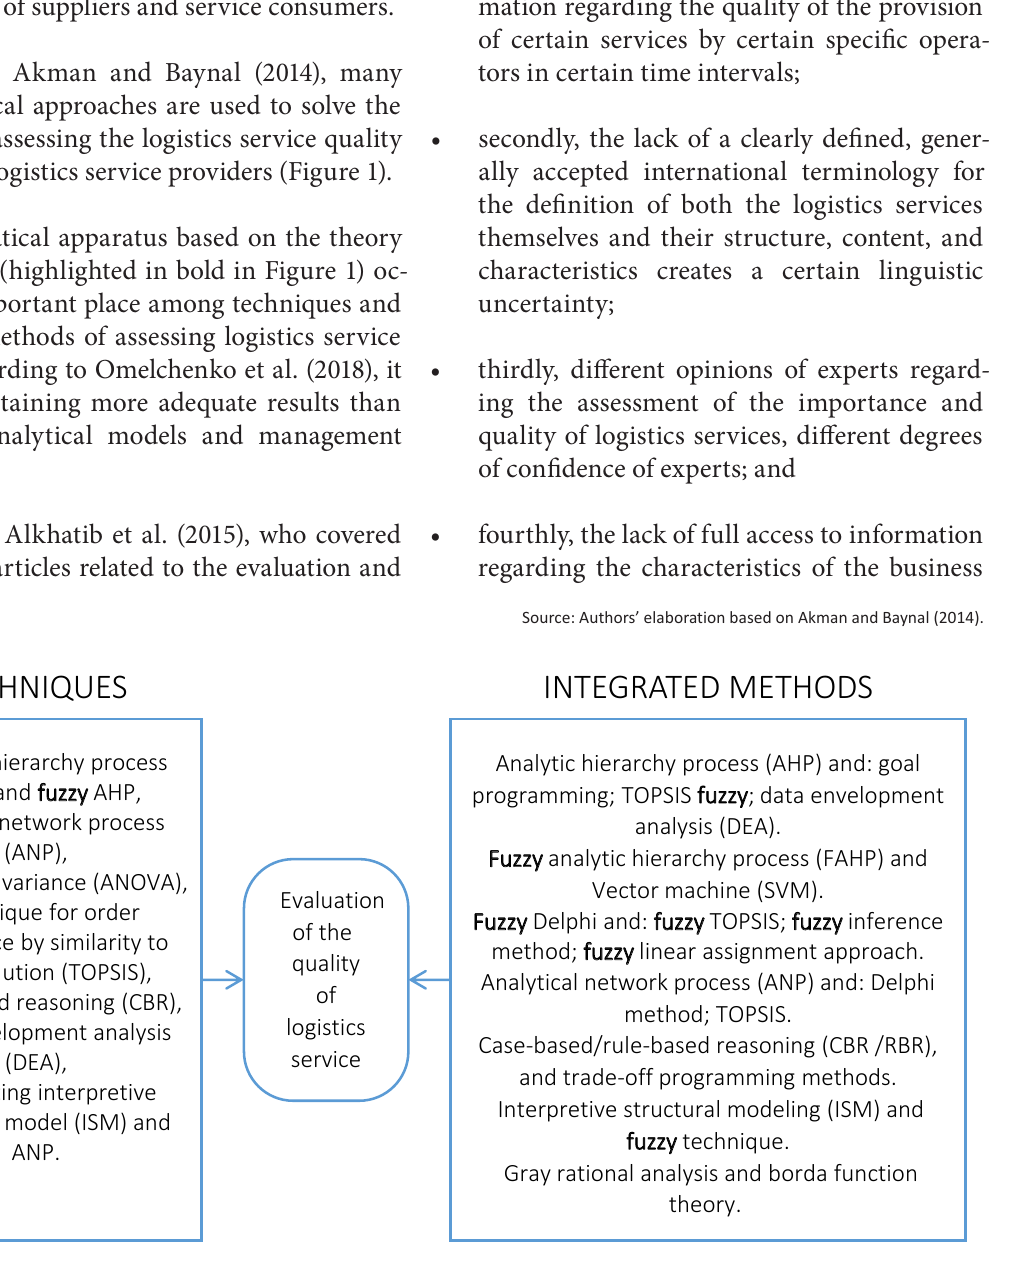
Figure 1. Techniques and methods of assessing the logistics service